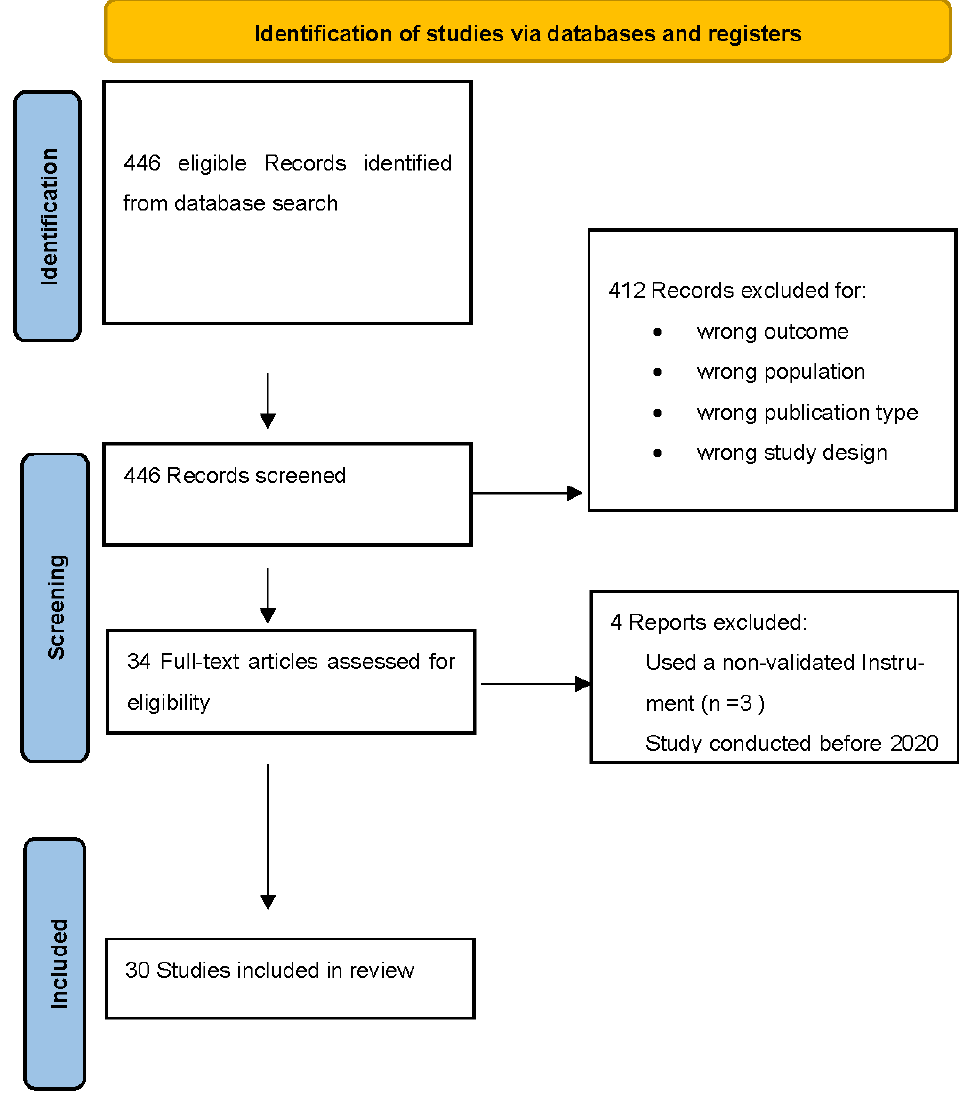
Figure 1. Study selection process.